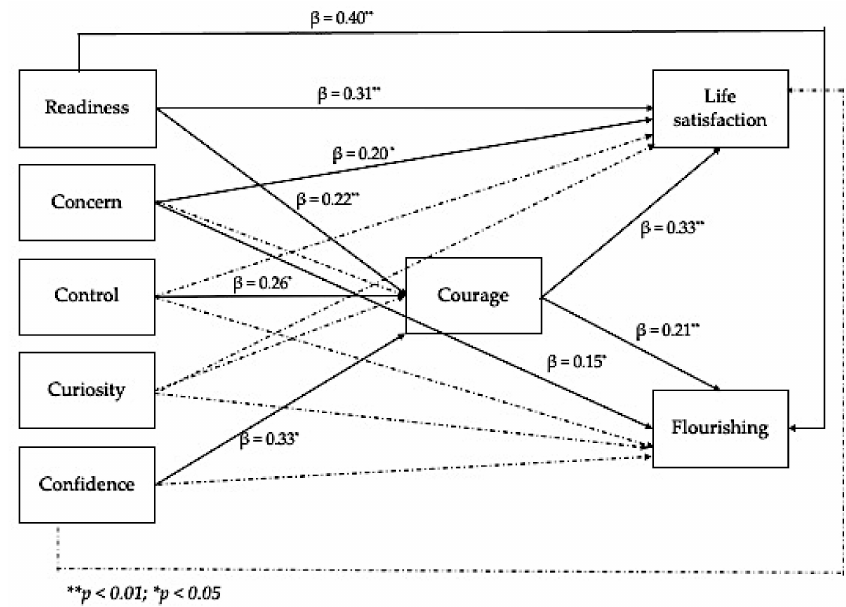
Figure 1. The structural model. Note. Dashed lines indicate nonsignificant